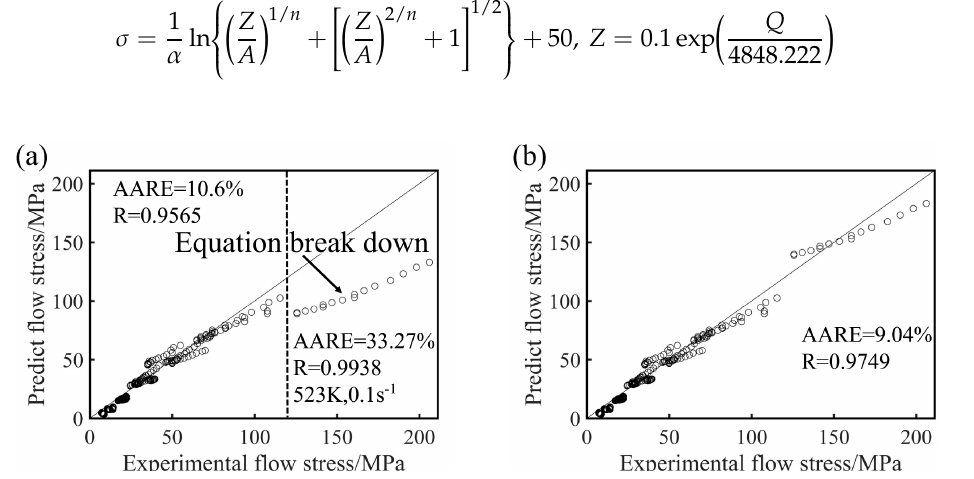
Figure 11. The comparison between the experimental flow stress and the flow stress predicted by the constitutive equation before ( a ) and after ( b ) inclusion of the additional stress.